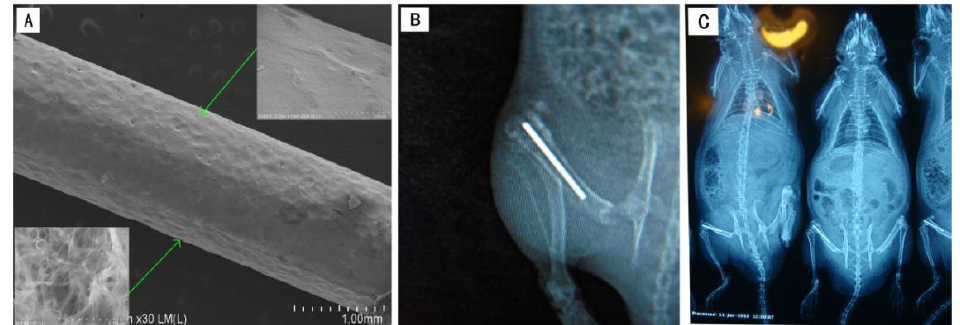
Figure 7. Surgical procedure and antibacterial efficacy in vivo. ( A ) HA/gentamicin/TNT rods ( B , C ) postoperative X ‐ ray with the implanted titanium rods in the tibia of rats.